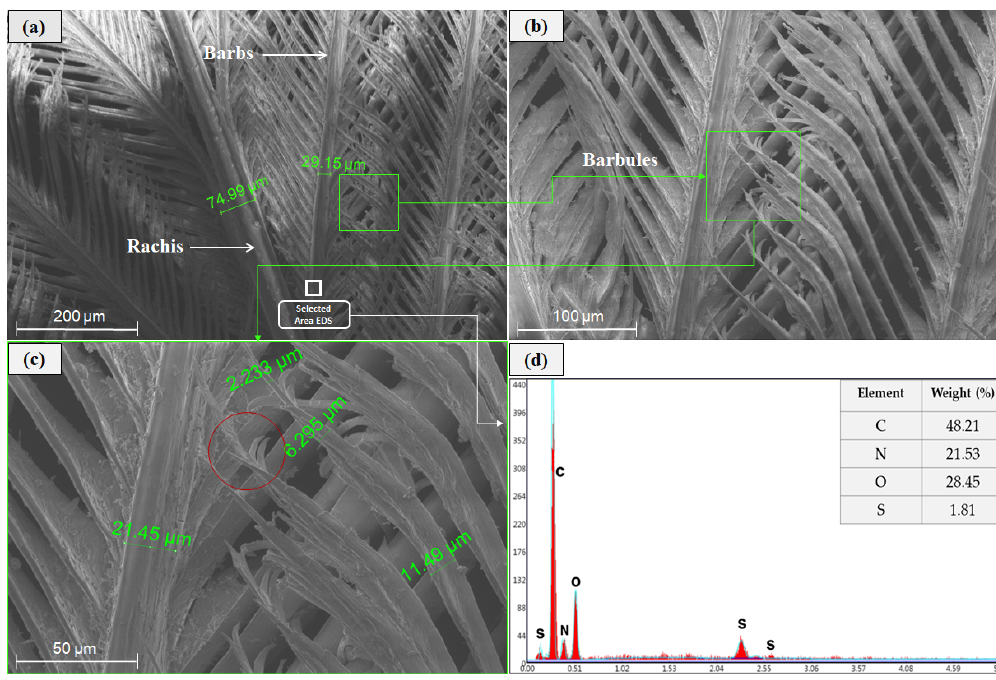
Figure 4. Scanning electron microscopy (SEM) of CFs: ( a ) Overall structure of CFs and selected area for energy dispersive X-ray spectroscopy (EDS) analysis; ( b , c ) overall structure of barbs and barbules; and ( d ) results of EDS analysis.